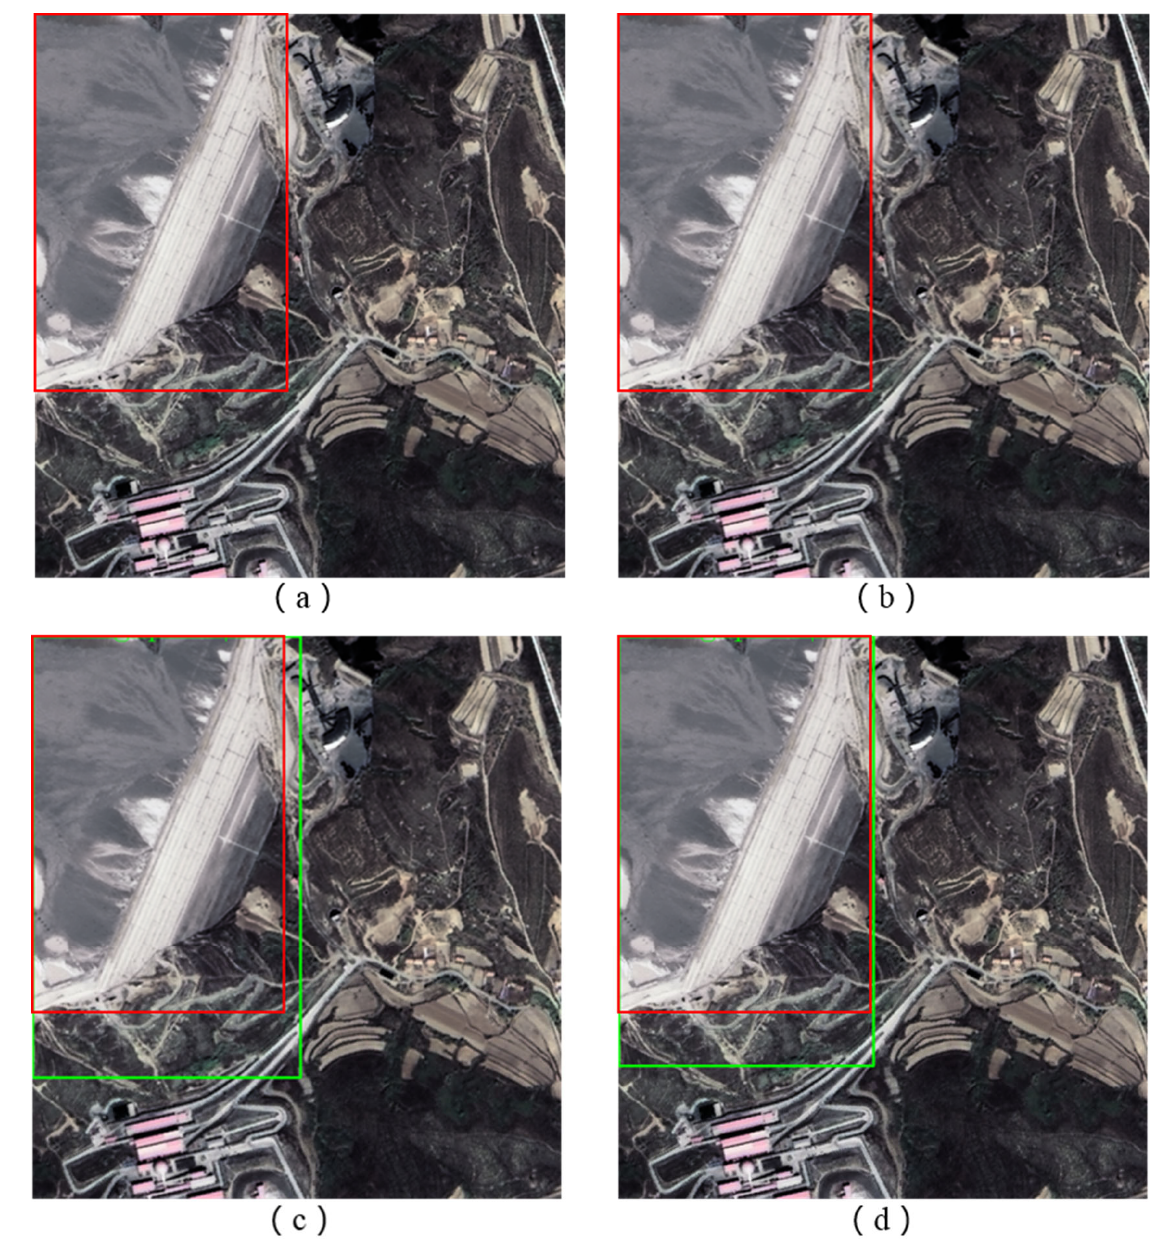
Figure 10. Improvement in missed detection and detection accuracy. ( a ) prediction result of the Bands_3 model, ( b ) prediction result of the Bands_4 model, ( c ) prediction result of the Bands_4_sub model, ( d ) prediction result of the Bands_4_sub_SAMB model, the red bounding box represents the GT of the tailings pond and the green bounding box represents the PT of the tailings pond.